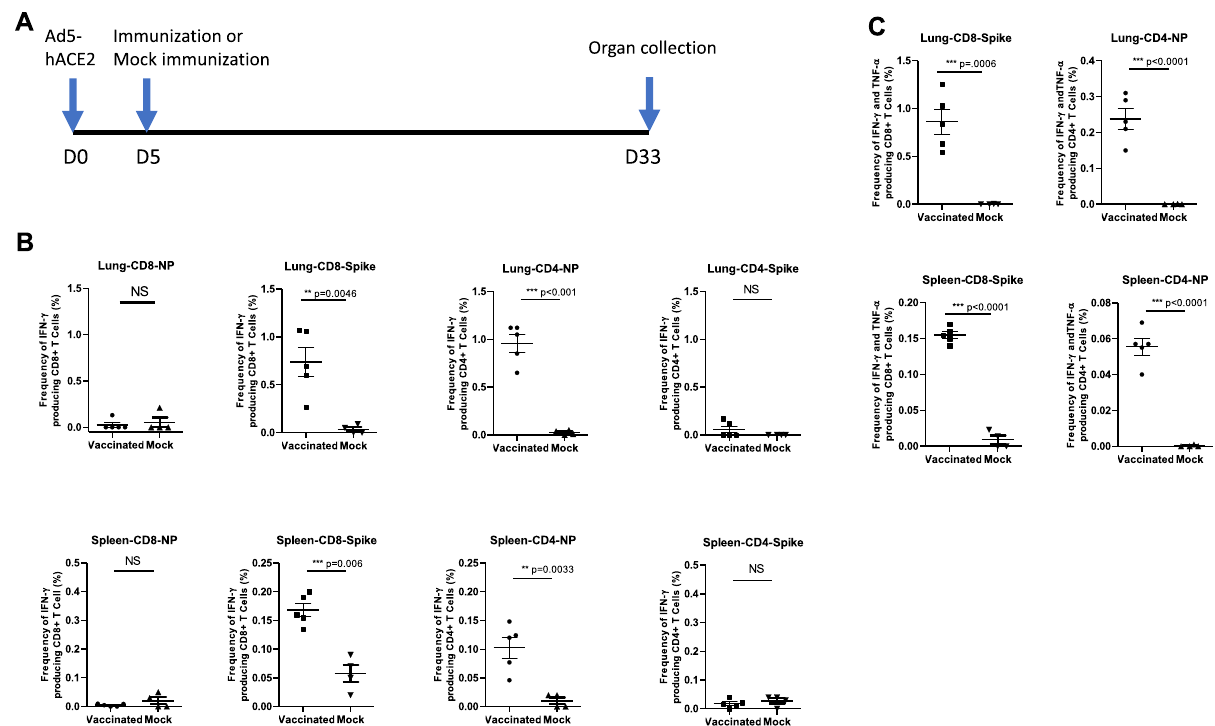
Fig. 5 T cell response to Ca-DelMut immunization in Ad5-hACE2 transduced mice. A Timeline of Ad5-hACE2 transduction and immunization of Ad5-hACE2 transduced mice with Ca-DelMut. B Ca-DelMut induces IFN- γ positive CD4 + and CD8 + T cell responses in Ad5-hACE2 transduced mice. Four weeks after immunization, splenocytes and lung cells were obtained and stimulated with either spike or NP peptide pools or incubated without peptides overnight in the presence of BFA. Surface markers were stained, and cells fi xed and permeabilized. Intracellular cytokines were then stained with antibodies. Sample data were acquired using a BD FACSAria III cell sorter. IFN- γ + CD4 + and CD8T cells in immunized ( n = 5) and naive groups ( n = 4) were compared. Statistical comparisons between means were performed by Student ’ s t -test (2-tailed): **** p < 0.0001, *** p < 0.001, ** p < 0.01, NS: not signi fi cant. C Frequency of polyfunctional IFN- γ /TNF- α double positive CD4 + and CD8 + cells in Ca-DelMut virus immunized ( n = 5) and naive mice ( n = 4). Statistical comparisons between means were performed by Student ’ s t -test (2-tailed): **** p < 0.0001, *** p < 0.001, ** p < 0.01, NS: not signi fi